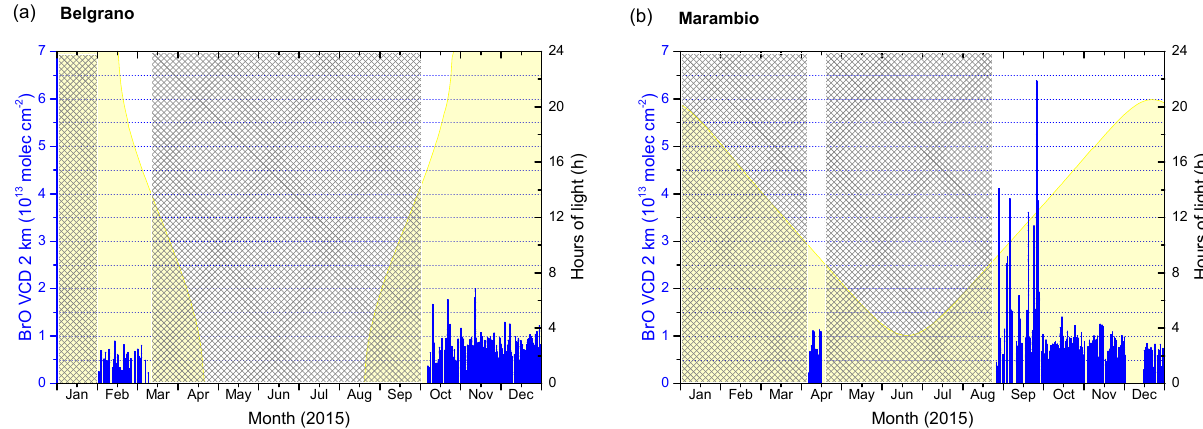
Figure 4. Time series of the BrO vertical column density (VCD) in the first 2km as observed at Belgrano (a) and at Marambio (b) during 2015. The horizontal scale indicates the time of the year while the left vertical scale shows the BrO VCD. The scale on the right shows the hours of light at each station (shown in yellow in the plots). Note that the same scales apply to both figures. Time periods without MAX-DOAS observations (i.e., instrumental issues or SZA>75 ◦ ) are indicated with shaded